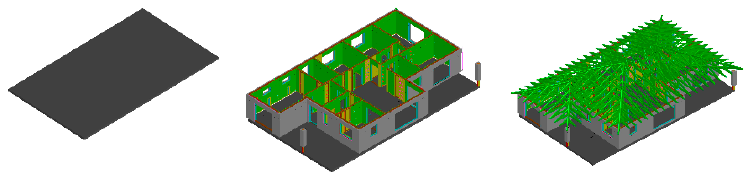
Figure 2. Assembly process of an object with a truss roof.